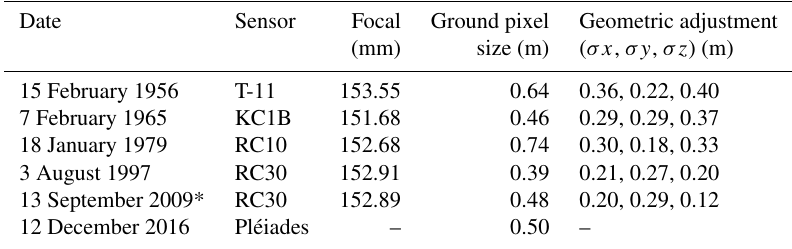
Table 1. High-resolution remote sensing data used in this